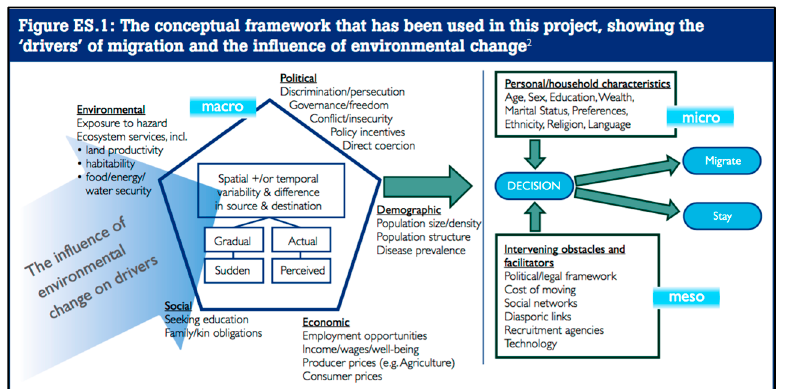
Figure 2. Conceptual model for understanding the role of the environment as one of many drivers of migration [30]. This model is reproduced from the UK Foresight Report (2011) and is intended to demonstrate the complexity of the contextual factors that can lead to migration [30]. (Contains public sector information licensed under the Open Government Licence v3.0.) This paper focuses on the role of climate change as an environmental driver, but we also discuss the relative roles of political and economic factors as stabilizing and/or destabilizing forces.